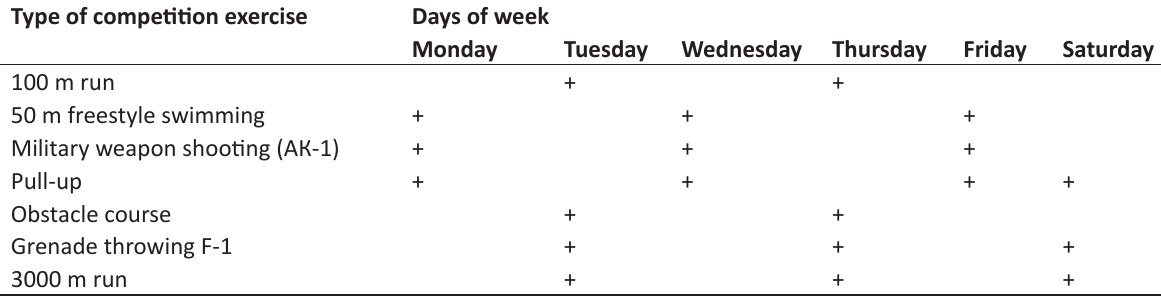
Table 1. Week distribution of a training load by types of multiathlon Type of competition